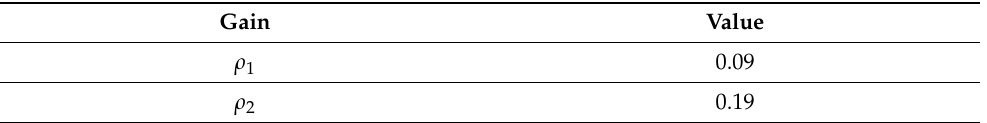
Figure 16. Dilution rate ( D in , c ) generated by FPGA and Matlab. Initially, the optimization algorithm requires eighteen days to reach the optimal point, as shown in Figure 15. The super-twisting controller requires this period for the control error to converge to zero using the gains specified in Table 4. In this transitory period, the GSS algorithm is initialized with 105 mL[ H 2 ] mL − 1 d − 1 and this value was taken as the initial reference for the DTSTC. Table 4. Discrete time super-twisting controller